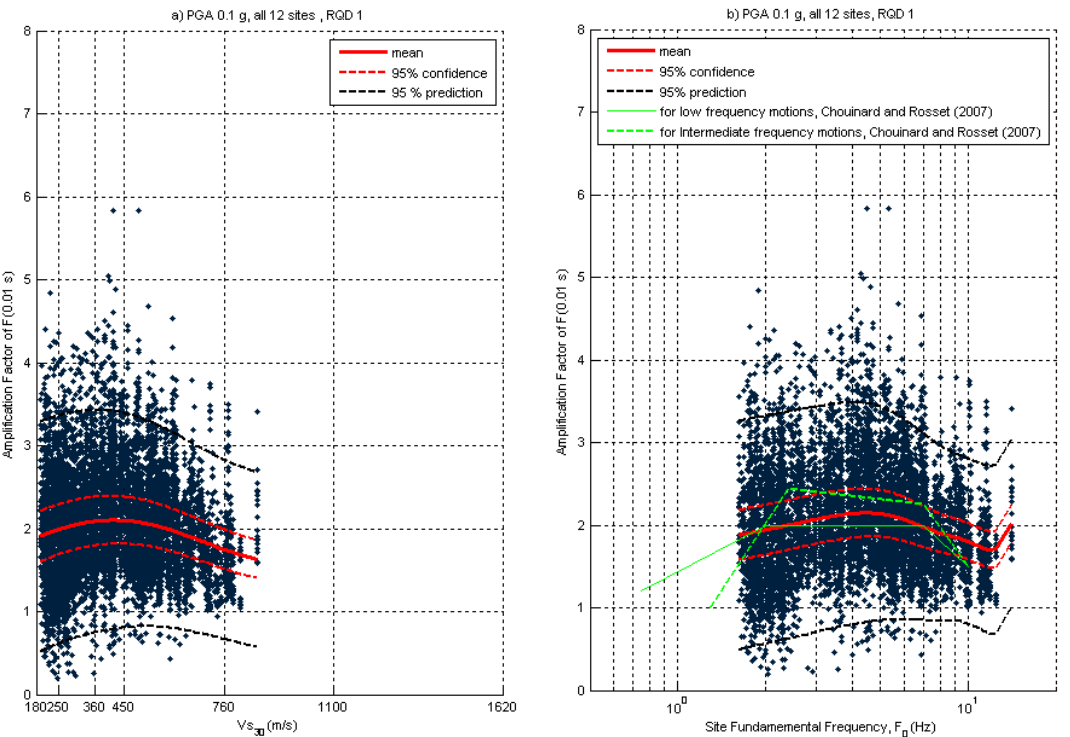
Figure 10. Amplification factors at T = 0.01 s for rock quality designation (RQD) of 1 (Vs = 1200 m/s) and PGA of 0.1 g: ( a ) as a function of Vs 30 , ( b ) as a function of site fundamental frequency F 0 .